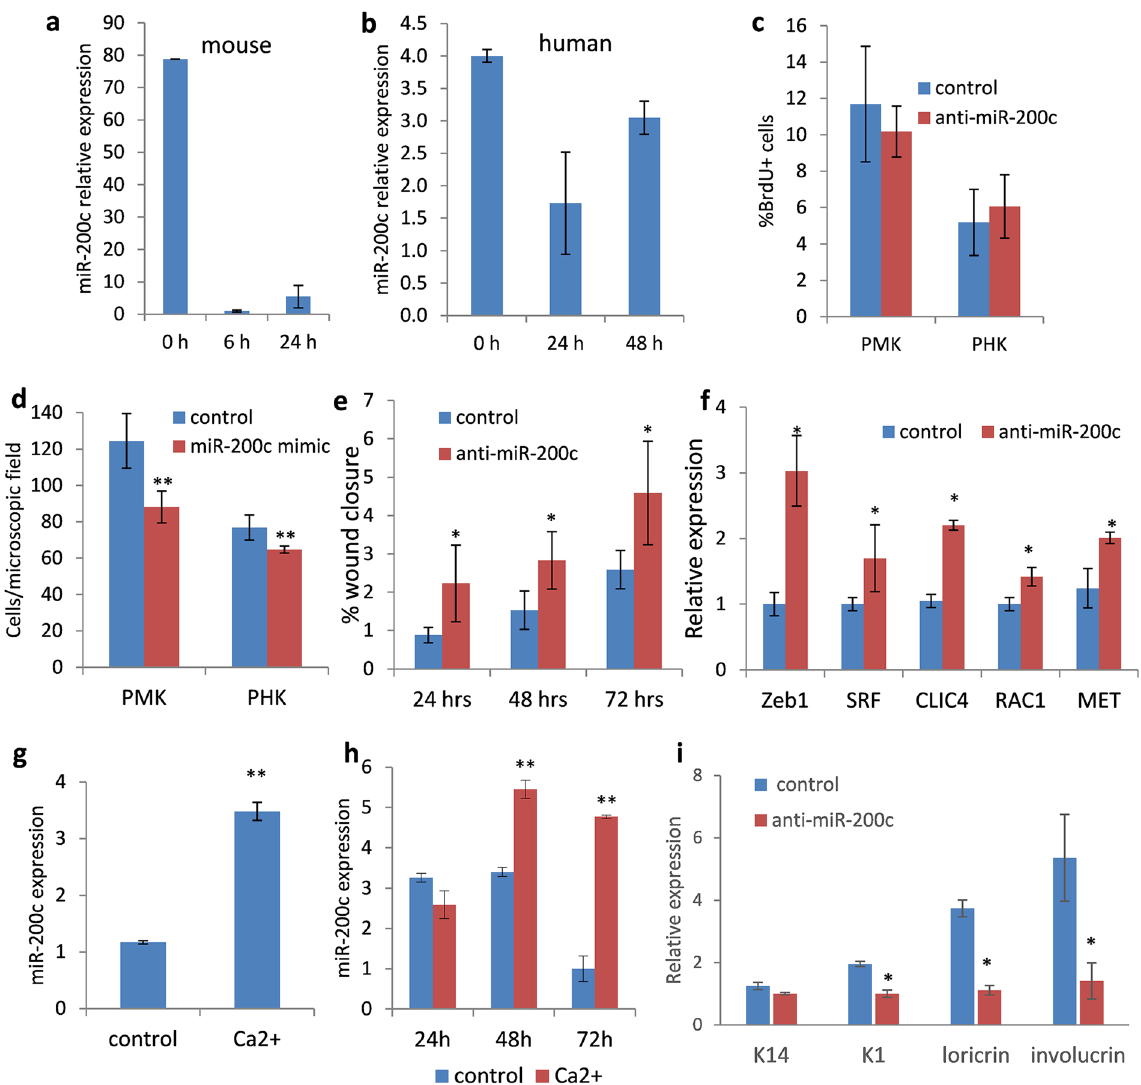
Figure 2. miR-200c exerts negative effects on keratinocyte migration and positive effect on keratinocyte differentiation. ( a ) RT-qPCR: dramatic decrease in miR-200c expression in primary mouse keratinocytes during scratch wound healing assay in vitro ; ( b ) RT-qPCR: downregulation of miR-200c expression in primary human keratinocytes during scratch wound healing assay in vitro ; ( c ) Lack of difference in the number of BrdU + cells in both mouse (PMK) and human (PHK) keratinocytes transfected with miR-200c inhibitor versus scrambled RNA control; ( d ) miR-200c mimic suppresses migration of both human and mouse keratinocytes. Transwell migration assay: primary mouse or human keratinocytes were transfected with miR-200c mimic or negative control RNA and allowed to migrate for 48 hours (n = 3; mean ± SE; ** p < 0.001; Wilcoxon rank sum test); ( e ) Scratch assay: primary mouse keratinocytes transfected with miR-200c inhibitor exhibited accelerated migration compared to the negative control (n = 3; mean ± SD; * p < 0.05; Student’s t test); ( f ) RT-qPCR: Accelerated wound closure induced by anti-miR-200c is associated with upregulation of genes controlling cell migration, including Zeb1, Srf, Clic4, Rac1, Met in mouse keratinocytes treated with miR-200c inhibitor (n = 3; mean ± SD; * p < 0.05; Student’s t test); ( g ) Ca 2 + -induced differentiation in mouse primary keratinocytes; increase in the expression of miR-200c 48 hours after Ca 2 + treatment (n = 3, mean ± SD; ** p < 0.01; Student’s t test); ( h ) Ca 2 + -induced differentiation in human keratinocytes; increase in the expression of miR-200c at 48 h and 72 h after Ca 2 + treatment (n = 3, mean ± SD; ** p < 0.01; Student’s t test); ( i ) Ca 2 + -induced differentiation in mouse keratinocytes; downregulation of Loricrin and Involucrin expression in primary mouse keratinocytes transfected with miR-200c inhibitor 48 hours after Ca 2 + treatment (n = 3, mean ± SD; * p < 0.05; Student’s t